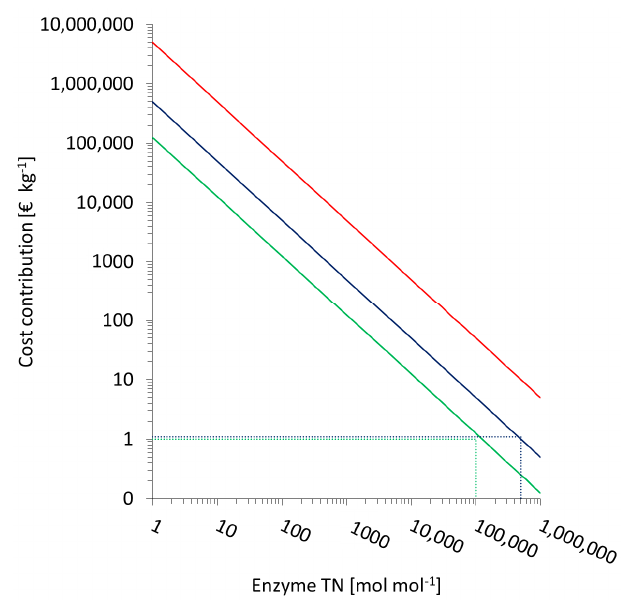
Figure 1. Cost contribution of a biocatalyst to the final product depending on the number of catalytic cycles performed (turnover number, TN = mol product × mol − 1enzyme ). Assumptions: molecular weight of the product: 200 g × mol − 1 ; molecular weight of the enzyme: 200 kDa, green : enzyme costs = 250 € kg − 1 , blue : enzyme costs = 1000 € kg − 1 , red : enzyme costs = 10,000 € kg − 1 .